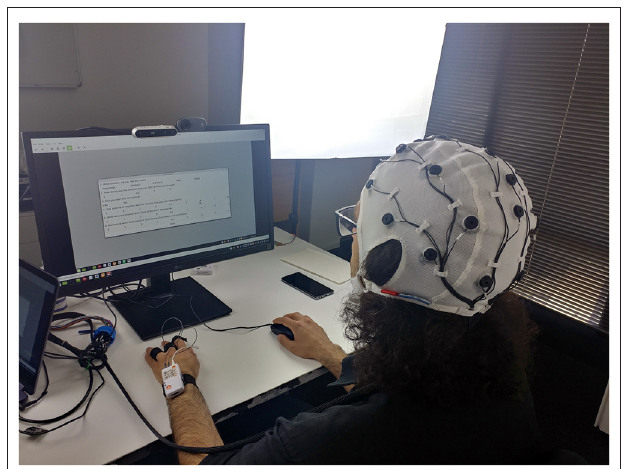
FIGURE 2 | The experiment